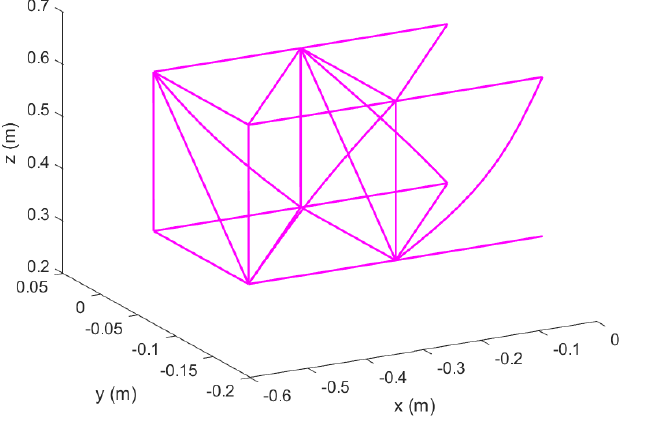
Figure 44. Mode 5 of Timoshenko beams in Topology 2 with hinged ends; original